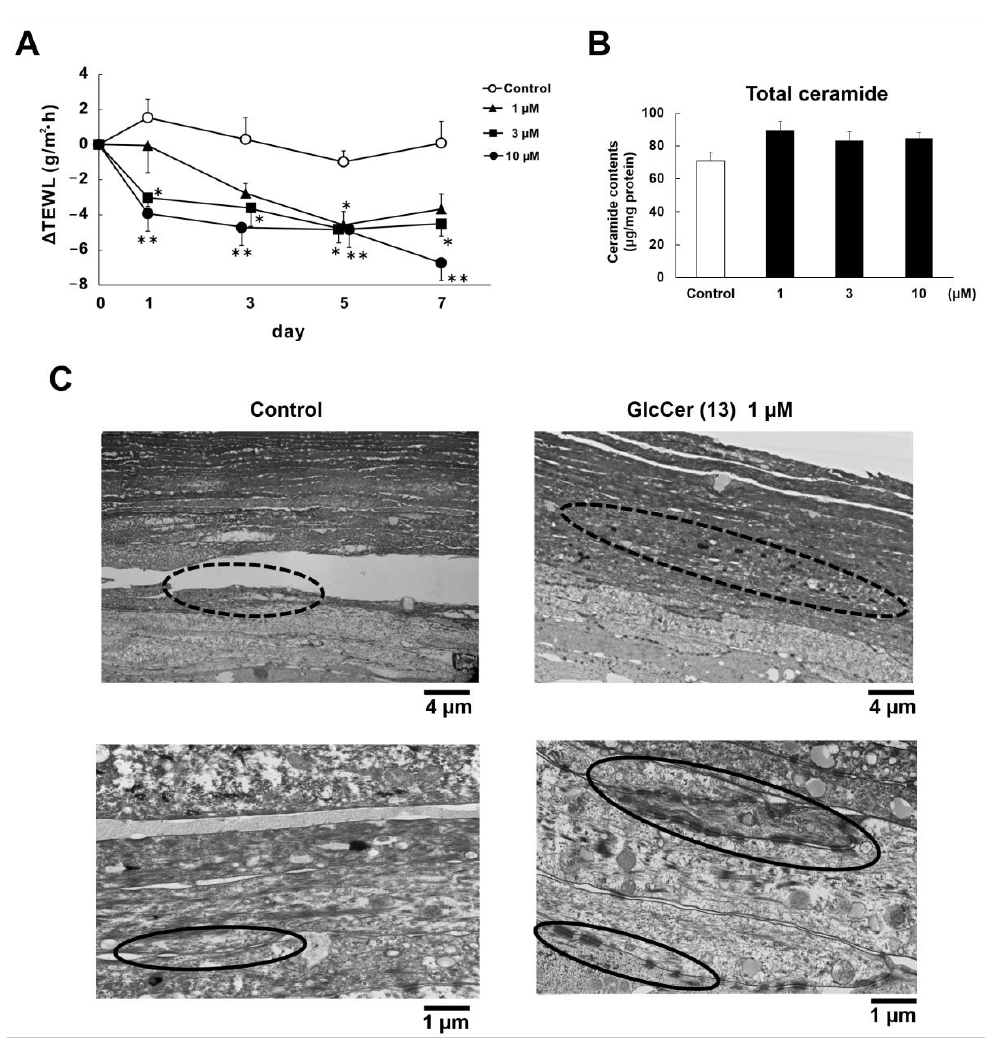
Figure 7. Effects of GlcCer[d18:2(4 E ,8 Z )/26:0)] ( 13 ) on epidermal hydration factors in the RHEK model. ( A ) Changes in TEWL (n = 6); ( B ) SC Cer contents after the treatment with 13 for 7 days (n = 4); ( C ) Electron microscopic analysis of cross-sections of the RHEK model. Dotted and solid circles indicate keratohyalin granules and desmosomes, respectively. All data are expressed as means ± S.E. Asterisks denote a significant difference from the control group, * p < 0.05, ** p <